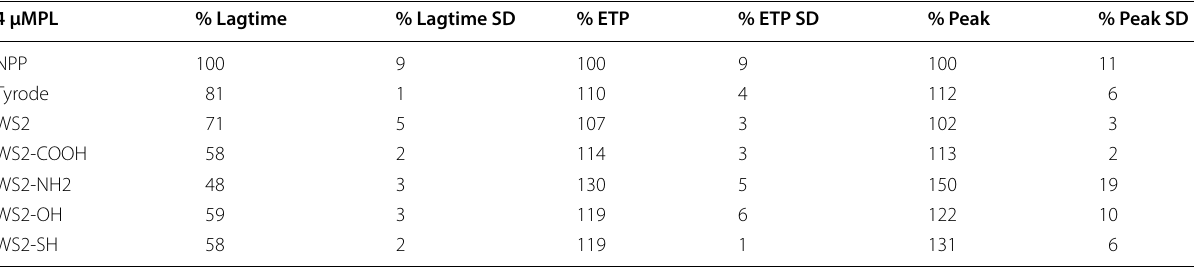
at 100 µg/mL on thrombin generation parameters induced by the intrinsic